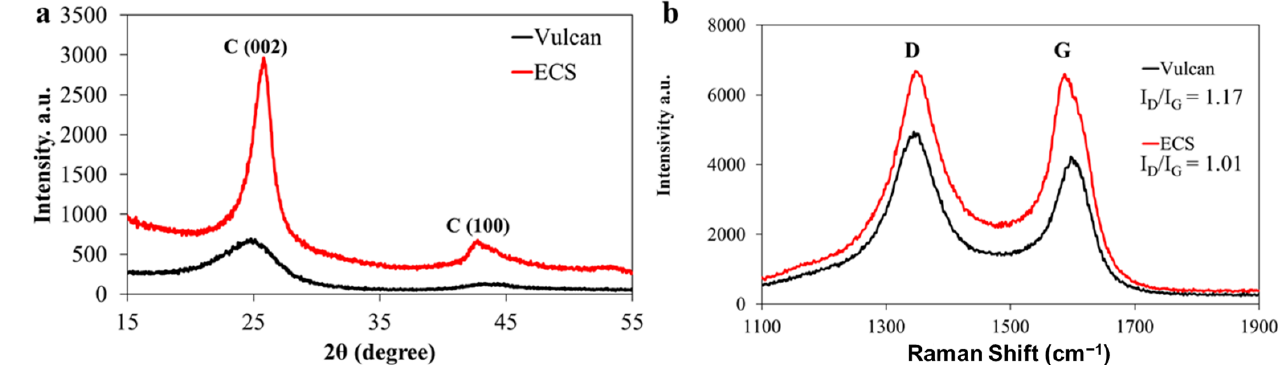
Figure 1. XRD patterns ( a ) and Raman spectroscopy ( b ) of carbon support.